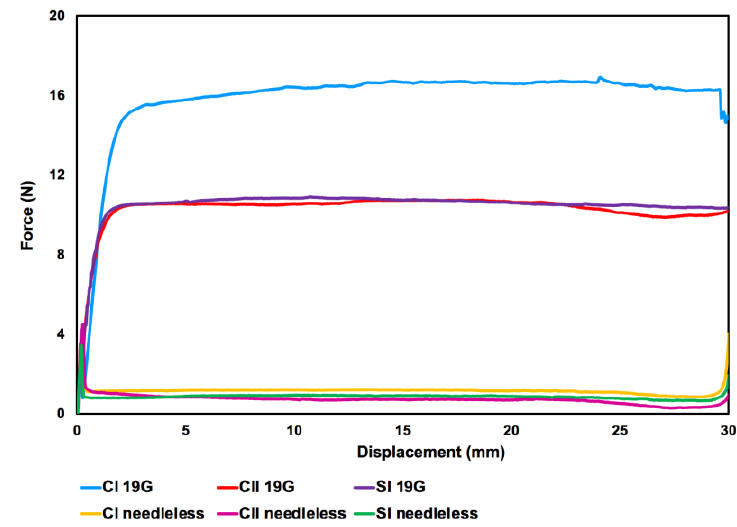
Figure 3. A representative graph of the injectability tests of hydrogel solutions via force versus displacement measurements. CI/II — define; 19G — define; SI — define. Table 3. Injectability force measurements of hydrogel solutions by 10 mL syringe (BD, tip inner and outer diameter of 2 and 4 mm, respectively) with and without a needle (19G × 1 1 / 2” 1 × 40mm). Initial glide force (IGF), dynamic glide force (DGF) and maximum force (F max ) values were counted as mean of three experiments ( n = 3) with standard deviations in Newton (N)